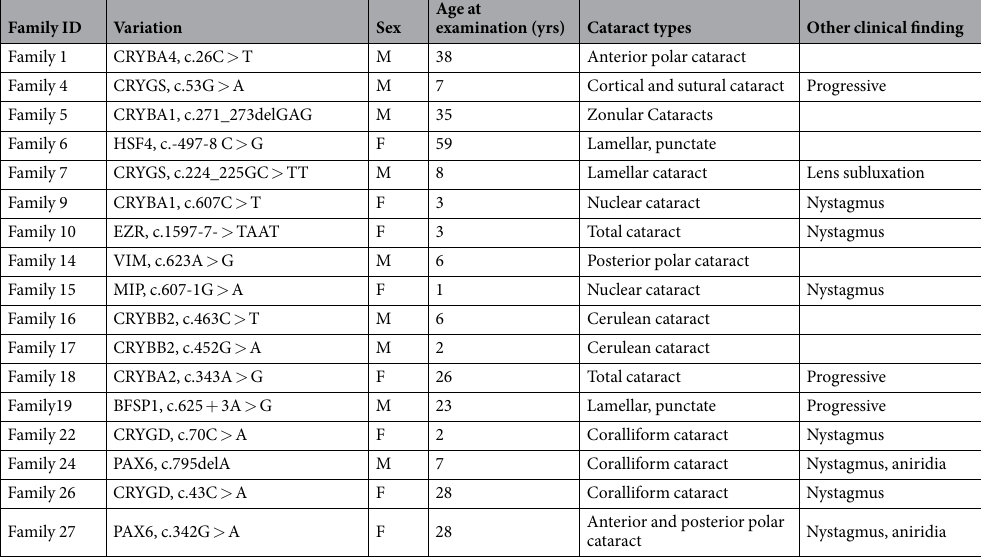
Table 2. Clinical features of affected probands with variants identified in this